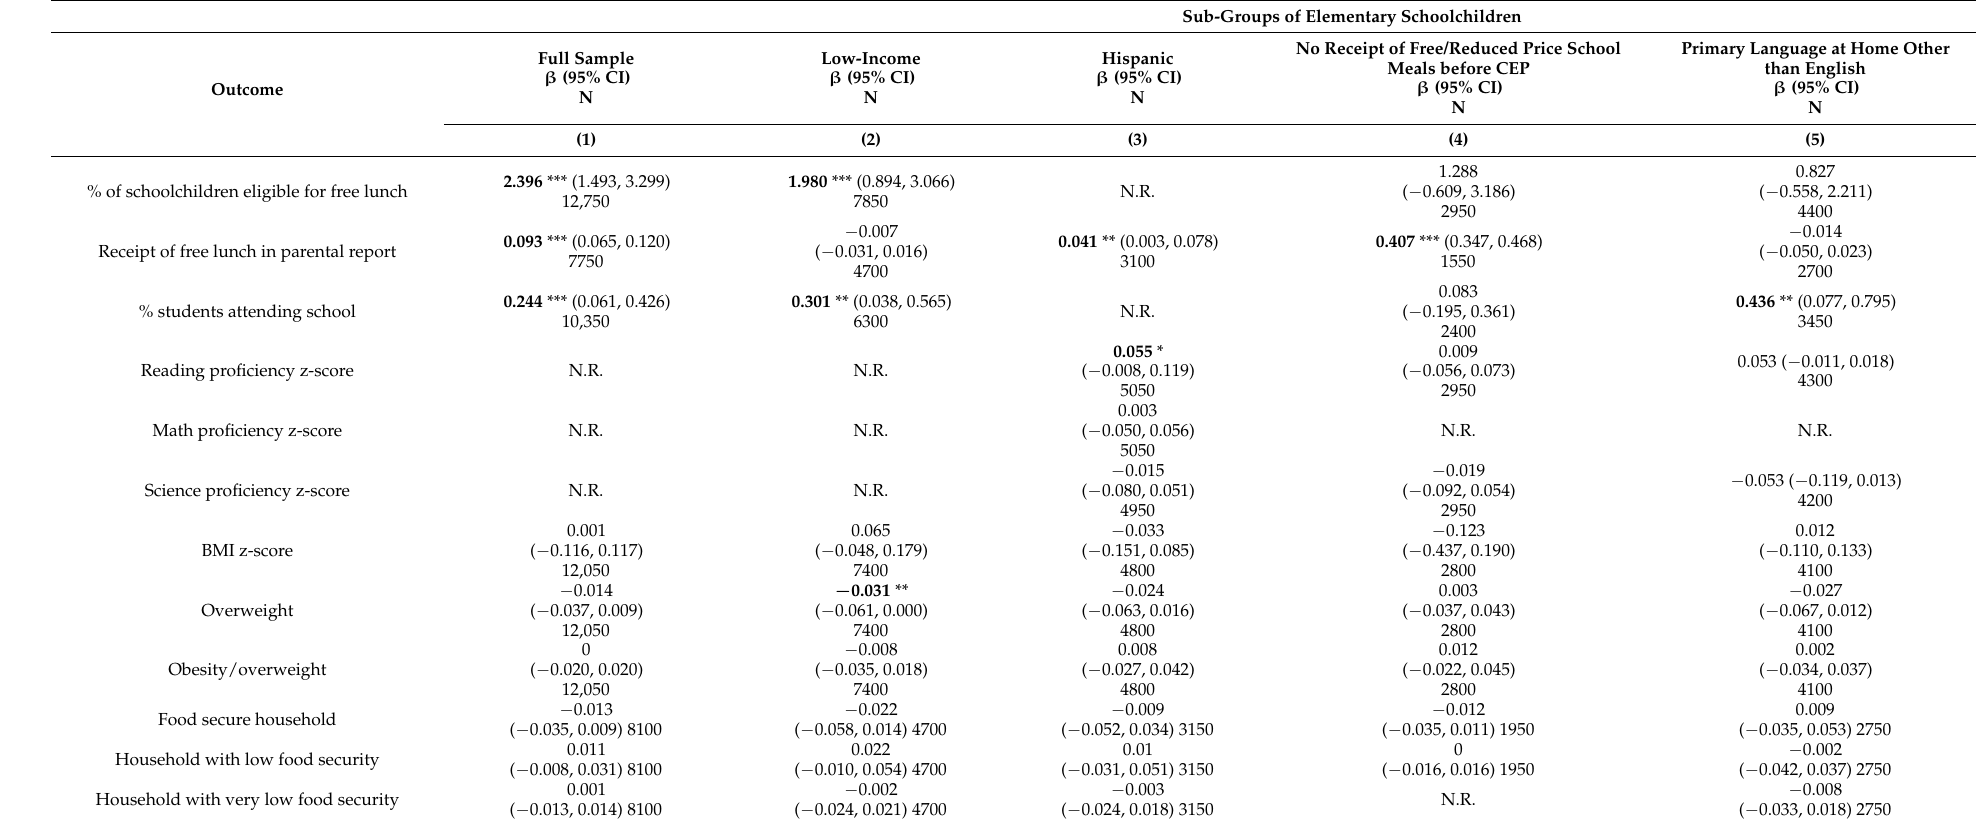
Table 3. Estimated CEP Effects on Elementary Schoolchildren,